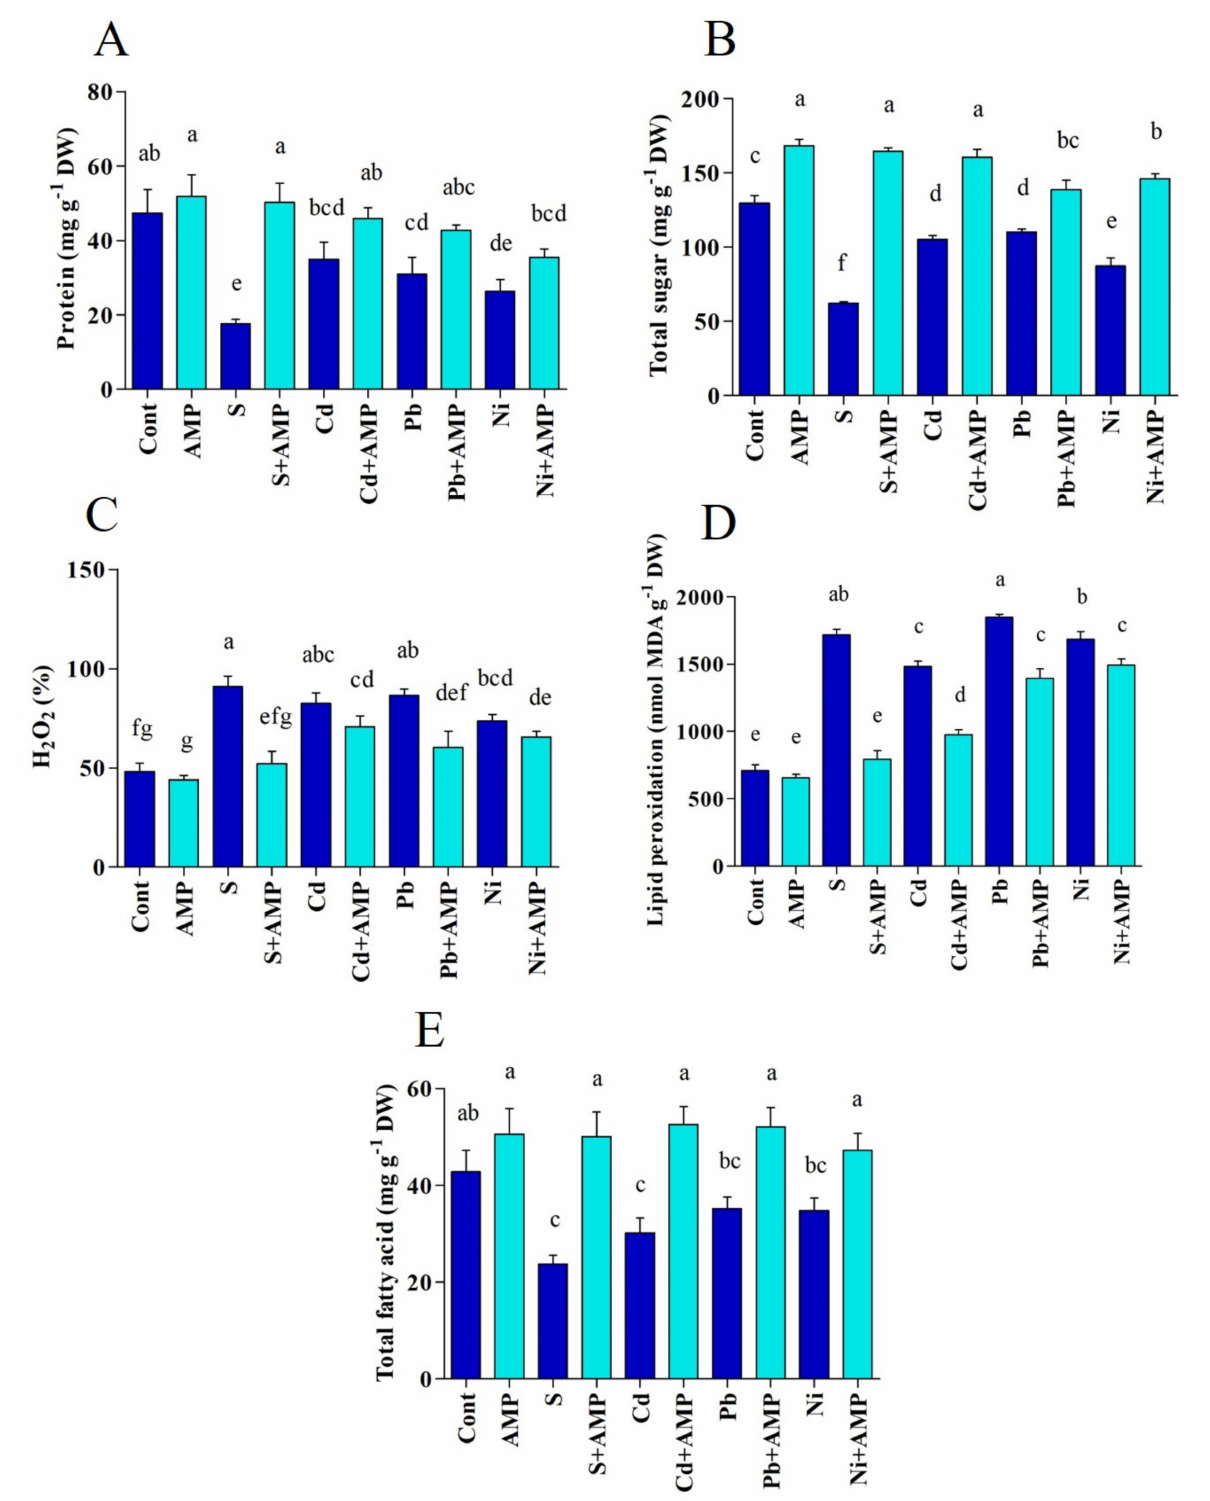
Figure 4. ( A ) Protein, ( B ) Sugar, ( C ) H 2 O 2 , and ( D ) MDA, ( E ) total fatty acid content in leaves of soybean grown under normal and stress conditions and treated with ampelopsin for 12 days (12DAT). Treatments: Cont (control), AMP (1 µ M ampelopsin), S (1.5% sodium chloride), AMP (1 µ M ampelopsin) + S (1.5% sodium chloride), Cd (3 mM cadmium), 1 µ M AMP (ampelopsin) + Cd (3 mM cadmium), Pb (3 mM lead), AMP (1 µ M ampelopsin) + Pb (3 mM lead), Ni (3 mM nickel), and AMP (1 µ M ampelopsin) + Ni (3 mM nickel). Values show the means ± SE ( n = 5) and significant differences at p < 0.05 (Tukey test). Bars with different lowercase letters are significantly different from each